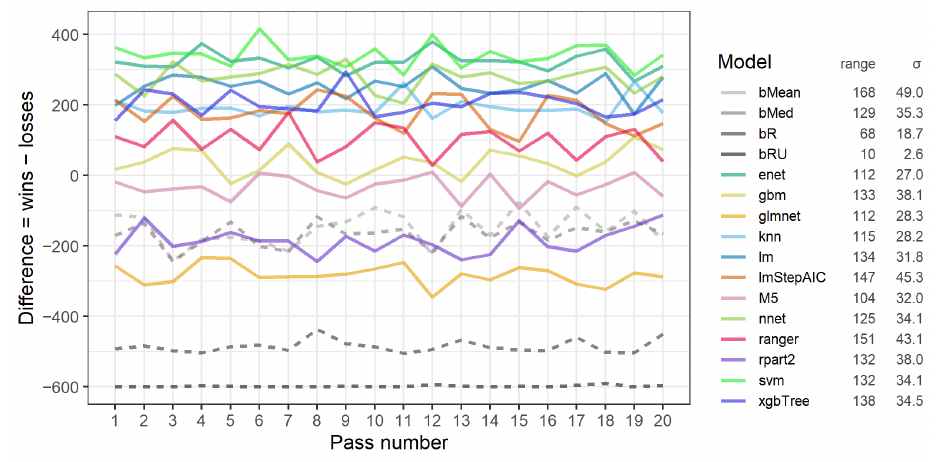
Figure 6. Stability of the difference for models across passes. Each data point denotes a difference for a particular model in a given pass across all investigated data